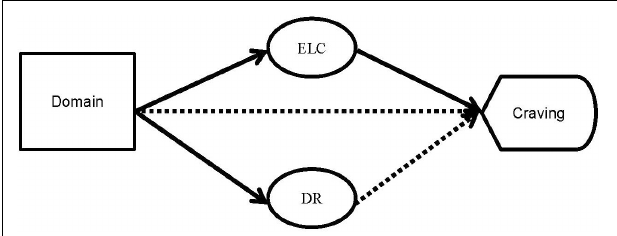
FIGURE 3 | Mediation model for the overall pattern of associations between domains, cognitive content and craving. N = 377 data sets from neutral as well as pre-binge EMA assessments were included from all available participants. Domains refer to either ‘ impaired autonomy/achievement, ’ ‘ disconnection, ’ or ‘ exaggerated inhibition. ’ DR, thoughts about dietary restraint; ELC, thoughts about eating and loss of control; —- statistically significant pathway, (cid:4) (cid:4) (cid:4) (cid:4) non-significant